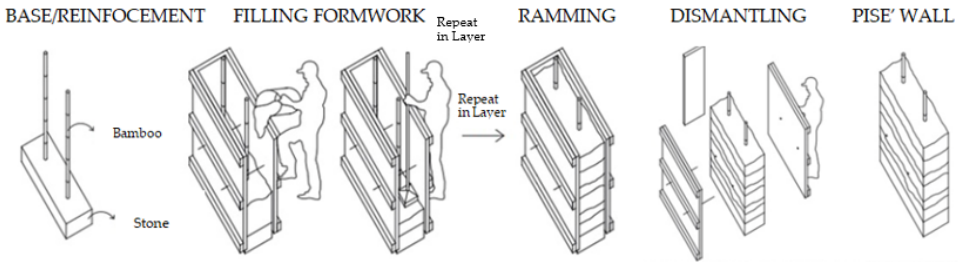
Figure 1. The production cycle of clay or pisé wall with reinforcement [8].